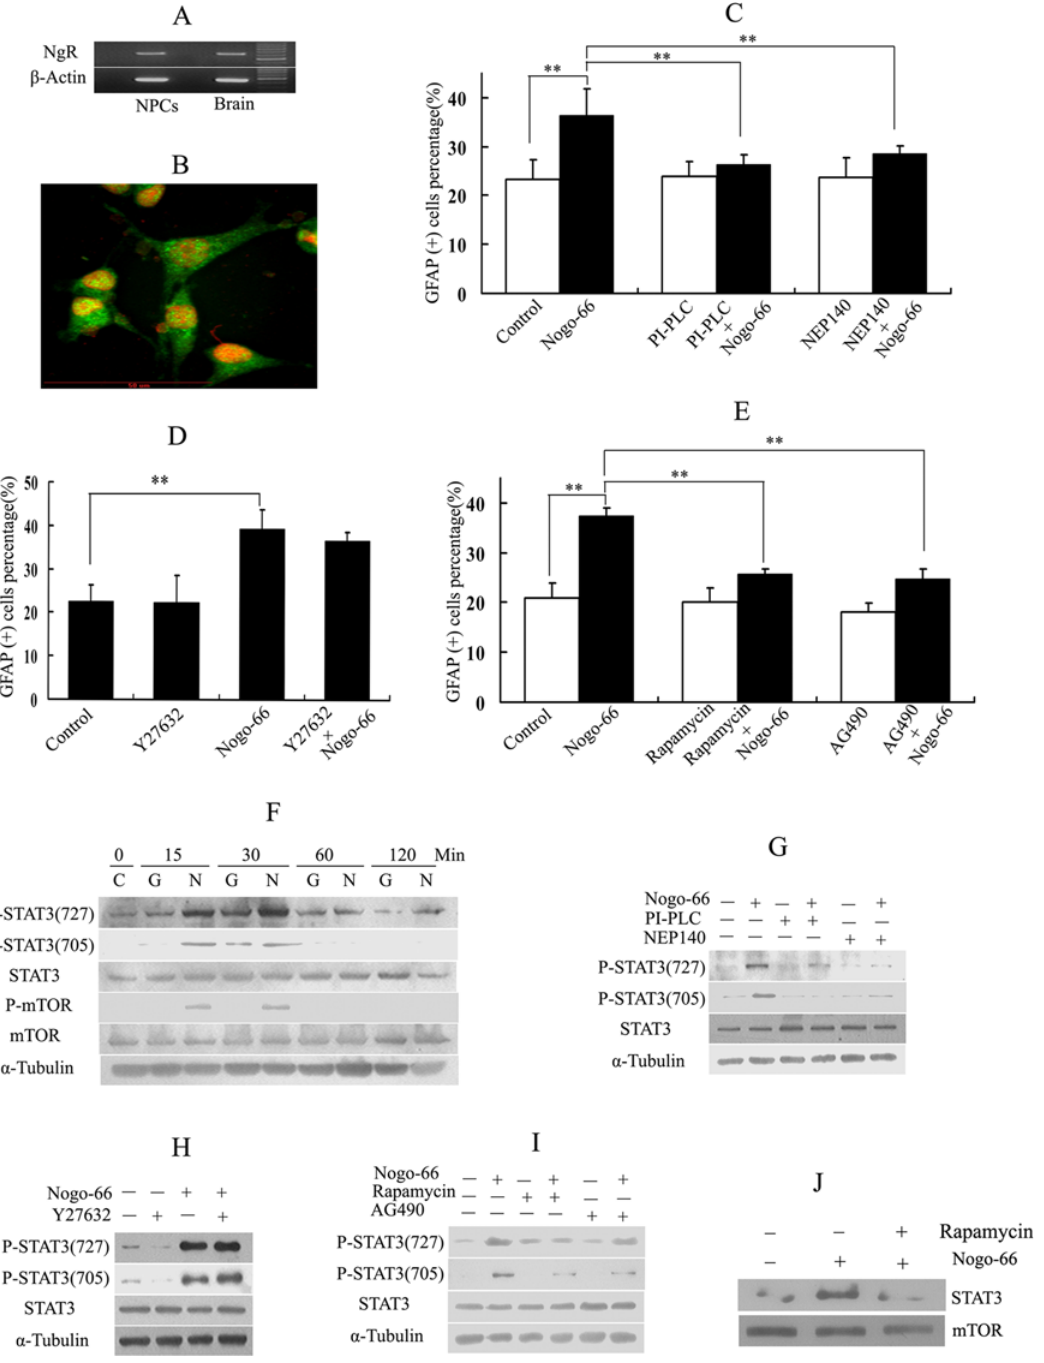
Figure 4. Nogo-66 activated mTOR-STAT3 signaling in NPCs astroglial differentiation. (A) Gel imagine of RT-PCR for NgR mRNA expression in NPCs. (B) Immunocytochemistry for NgR (green) expression in NPCs. Nuclei were stained by PI (shown in red). (C) PI-PLC and NEP1-40 rescued the astroglial induction by Nogo-66. After PI-PLC or NEP1-40 treatment for 2 hours, the proportion of GFAP positive cells induced by Nogo- 66 was significantly lower than that induced only by Nogo-66 treatment. ( p , 0.01). (D) The statistical result of GFAP positive cells percentage after Y27632 (RhoA-ROCK inhibitor) treatment. The astroglial induction of Nogo-66 was not rescued by Y27632. (E) Rapamycin and AG490 rescued the astroglial induction by Nogo-66. After rapamycin or AG490 treatment for 2 hours, the proportion of GFAP positive cells induced by Nogo-66 was recovered. ( F ) Nogo-66 activated the phosphorylation of STAT3 at Ser727 and Tyr705 and phosphorylation of mTOR. After starved for 24 hours in serum-free DMEM medium, total cell lysates from NPCs treated with GST (G) or Nogo-66 (N) (100 nM) for the indicated time were immunoblotted and probed with the indicated antibodies. ( G ) After starved for 24 hours in serum- free DMEM medium, total cell lysates from NPCs not treated ( 2 ) or treated ( + ) with PI-PLC (1 U/ml) or NEP1-40 for 2 hours and then stimulated with Nogo-66 (100 nM) for 30 minutes were immunoblotted and probed with the indicated antibodies. PI-PLC and NEP1-40 could rescue the phosphorylation of STAT3 activated by Nogo-66. ( H ) Y27632 did not alter the phosphorylation of STAT3 activated by Nogo0-66. After starved for 24 hours in serum-free DMEM medium, total cell lysates from NPCs not treated ( 2 ) or treated ( + ) with Y27632 (10 uM) for 2 hours and then stimulated with Nogo-66 (100 nM) for 30 minutes were immunoblotted and probed with